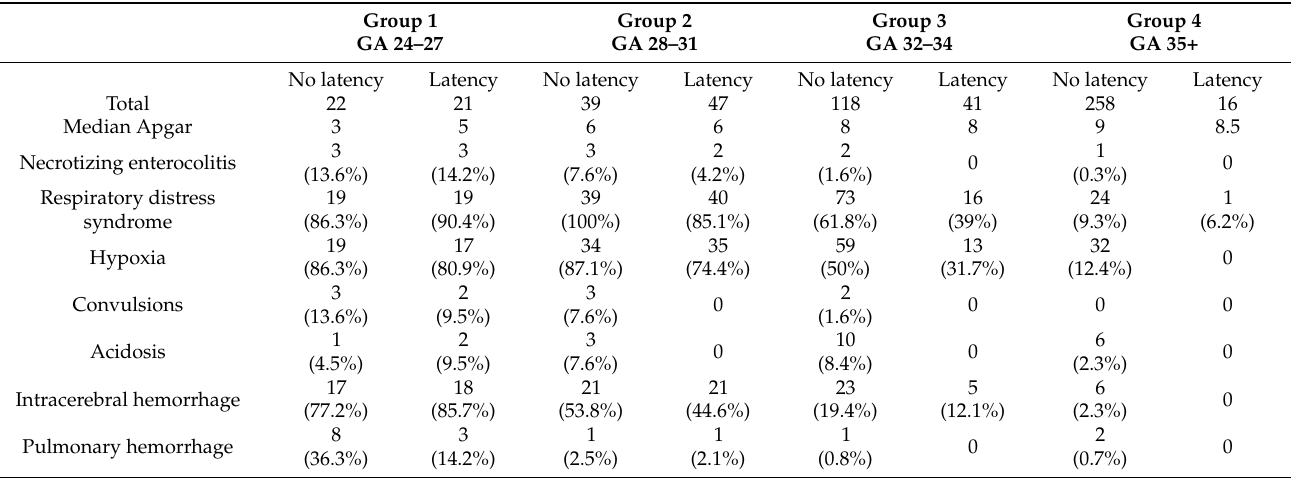
Table 4. Analysis of neonatal complications by gestational age groups, taking into account the existence or not of the latency